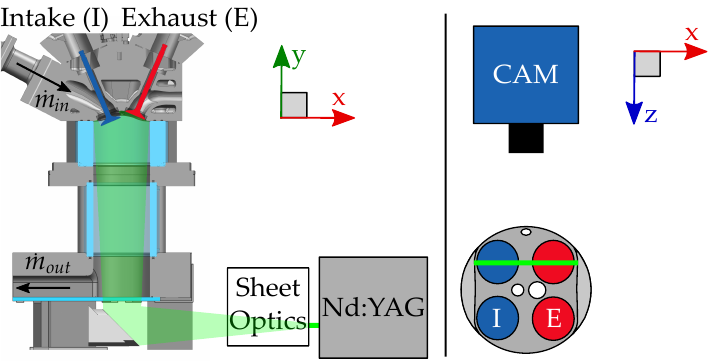
Figure 3. Arrangement of particle image velocimetry (PIV) measurement